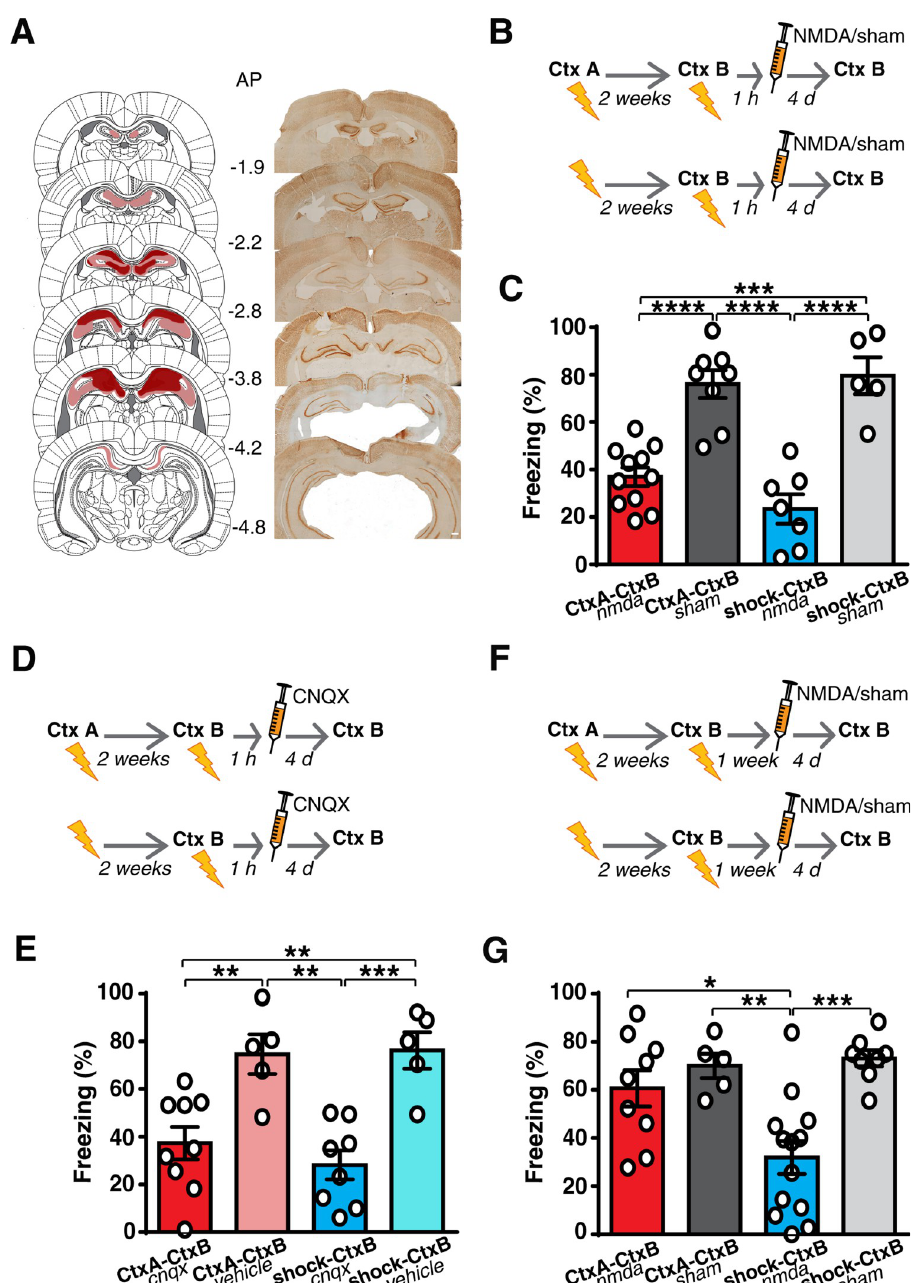
Fig 6. Prior contextual fear learning shortens the time window of hippocampal involvement in learning new associations. (A–C) Irreversible lesions of the dorsal hippocampus (CtxA-CtxB, n = 11, shock-CtxB, n = 7), impaired the formation of new memories in both groups when performed 1 h after learning as compared to sham-lesioned animals (CtxA-CtxB, n = 8, shock-CtxB, n = 5) (1-way ANOVA, F (3,27) = 23.59, p < 0.0001, η 2 = 0.7238; Tukey: CtxA-CtxB nmda vs. CtxA-CtxB sham, p < 0.0001; CtxA-CtxB nmda vs. shock-CtxB nmda , p = 0.2805; CtxA-CtxB nmda vs. shock-CtxB sham , p = 0.0001; CtxA-CtxB sham vs. shock-CtxB nmda , p < 0.0001; CtxA-CtxB sham vs. shock-CtxB sham , p = 0.9776; shock-CtxB nmda vs. shock-CtxB sham , p < 0.0001). Histological reconstruction of the excitotoxic lesions aimed at the dorsal hippocampus. Red and pink areas represent the smallest and the largest extension of the lesions. Numbers indicate posterior distance from bregma. Scale bar, 300 μ m. ( A ). (D and E) Similar results were obtained with reversible blockade of the hippocampus (CtxA-CtxB, n = 9, shock-CtxB, n = 8) with respect saline-injected rats (CtxA-CtxB, n = 5, shock-CtxB, n = 5) (1-way ANOVA, F (3,23) = 11.24, p < 0.0001, η 2 = 0.5945; Tukey: CtxA-CtxB cnqx vs. CtxA-CtxB vehicle , p = 0.0078; CtxA-CtxB cnqx vs. shock-CtxB cnqx , p = 0.7442; CtxA-CtxB cnqx vs. shock-CtxB vehicle ,